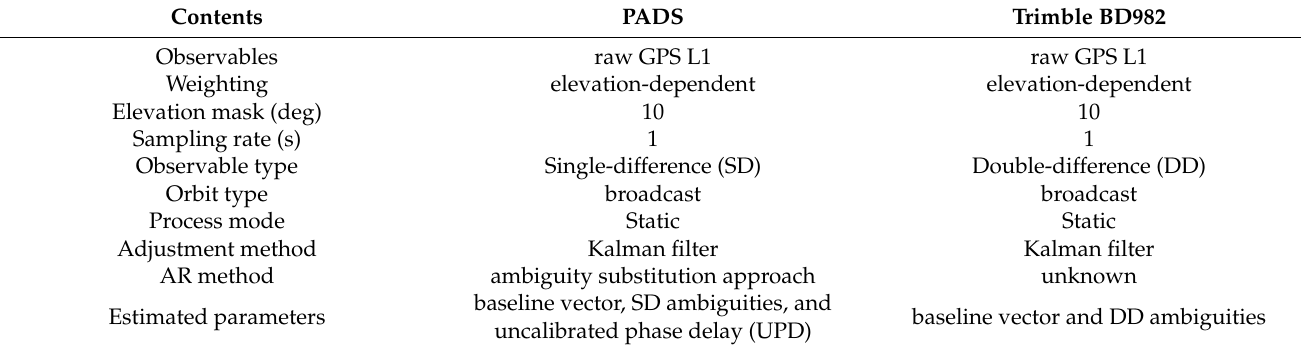
Table 1. Processing strategy of global positioning system (GPS) carrier phase observations for PADS and Trimble